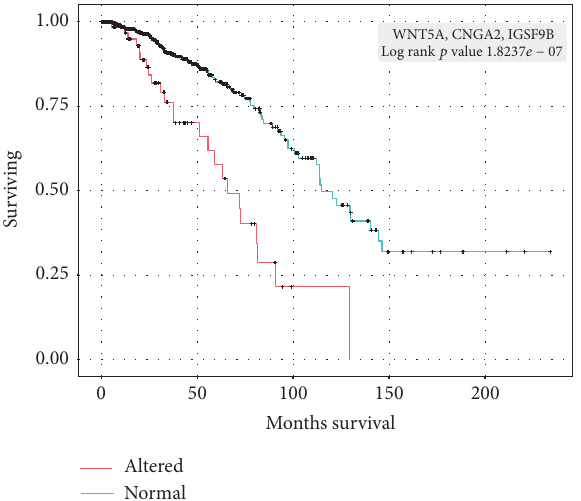
Figure 3: Kaplan-Meier overall survival curves in breast cancer patients. Samples were classified as having the three-gene signature (WNT5A, CNGA2, and IGSF9B) altered (red) or not